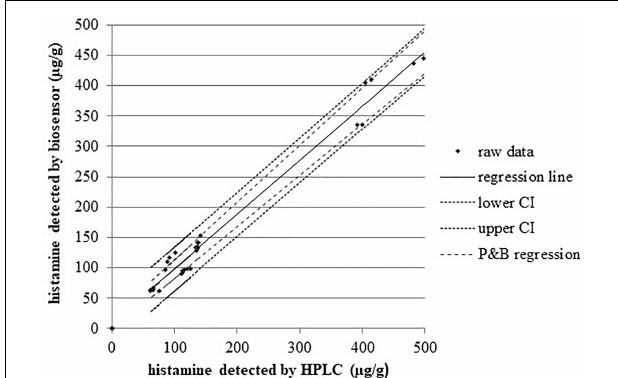
FIGURE 2 | Regression analysis of the two methods for histamine. n = 30, concentration range 75–498 µ g/g; Pearson correlation coefficient r = 0.99, P < 0.001. Kendall Tau coefficient 0.85, P < 0.001. R 2 = 0.98. Regression line equation: y = 8.85 + 0.89 x ; confidence interval CI95% for the intercept